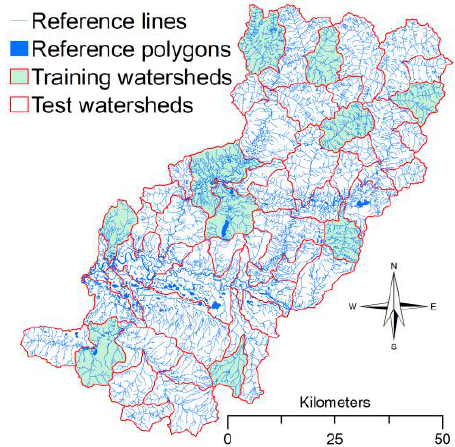
Figure 4. Reference 1:24,000-scale hydrographic features with training and testing watersheds for the base model study